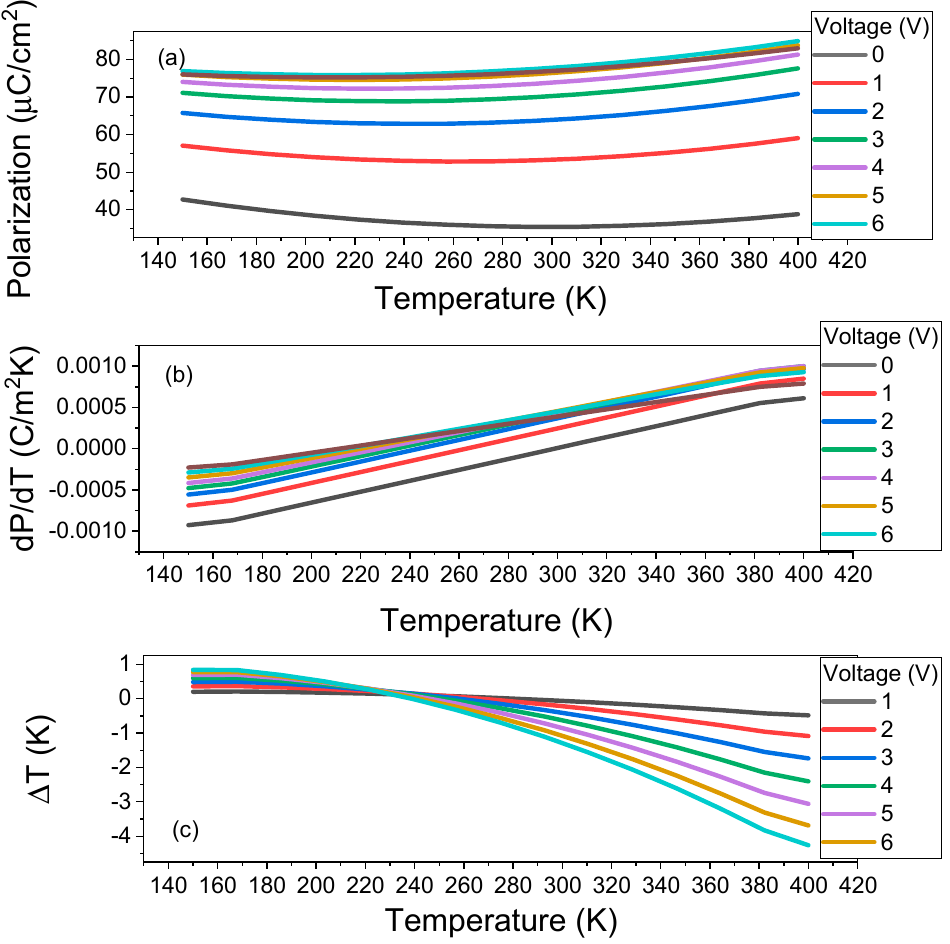
Figure 6. ( a ) The temperature dependence of polarization after switching for different voltages; ( b ) the indirectly evaluated pyroelectric coefficient as a function of temperature and different voltages; ( c ) the indirectly deduced adiabatic temperature variation as a function of temperature and voltages for epitaxial thin film BST/PZT/SRO/STO.